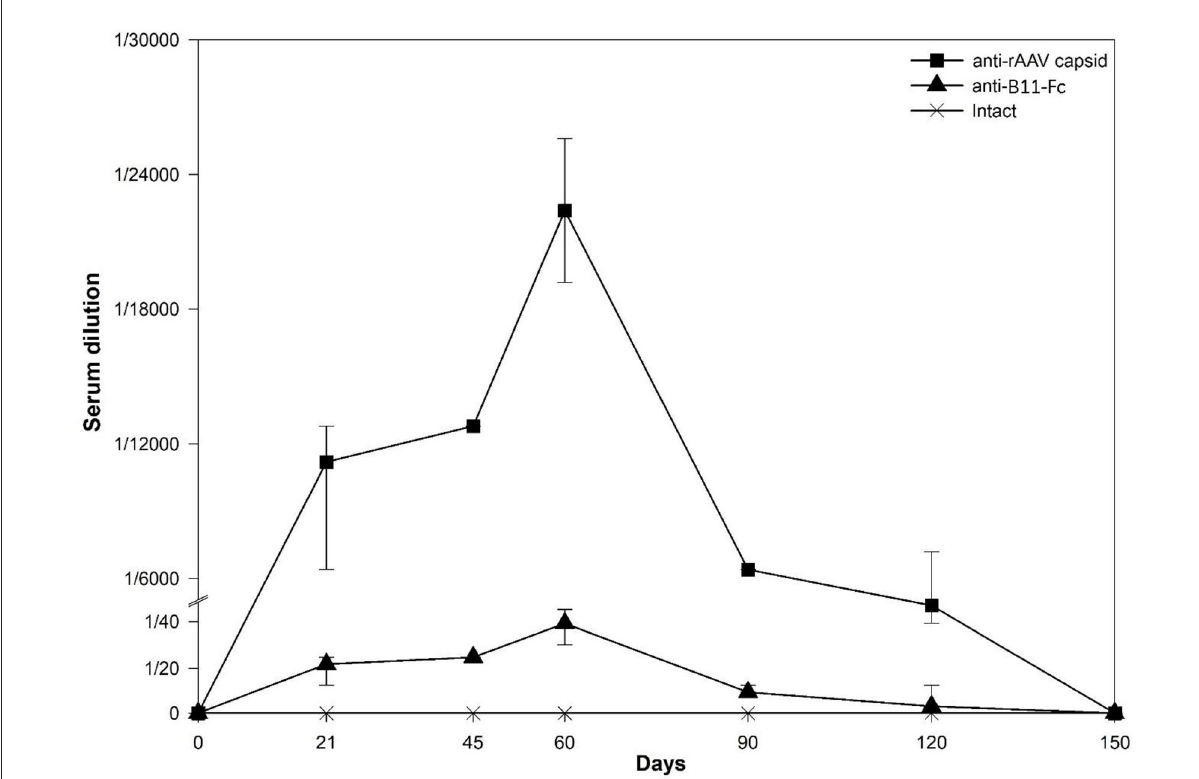
FIGURE5 Determination of antibody concentration to expressed injected rAAV-B11-Fc antibodies (anti-B11-Fc) and antibodies to rAAV capsid proteins (anti-rAAV) following the administration of 10 11 gc/mouse rAVV dose. Anti-rAAV capsid - the amount of anti-rAAV antibodies in mice serum, anti-B11-Fc - the amount of anti-B11-Fc antibodies in mice serum, intact - the amount of anti-B11-Fc and anti-rAAV antibodies in serum of untreated